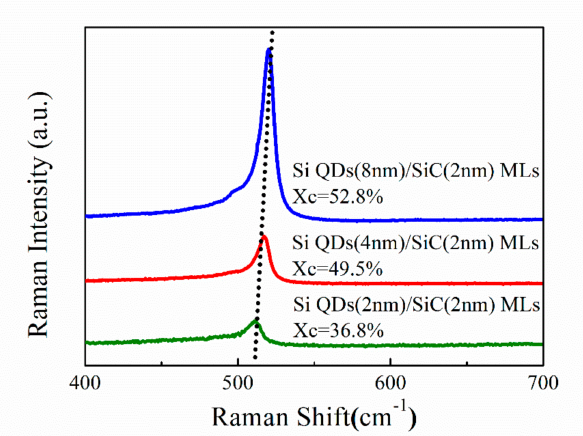
Figure 2. Raman spectra of Si QDs / SiC MLs undergoing annealing at 900 ◦